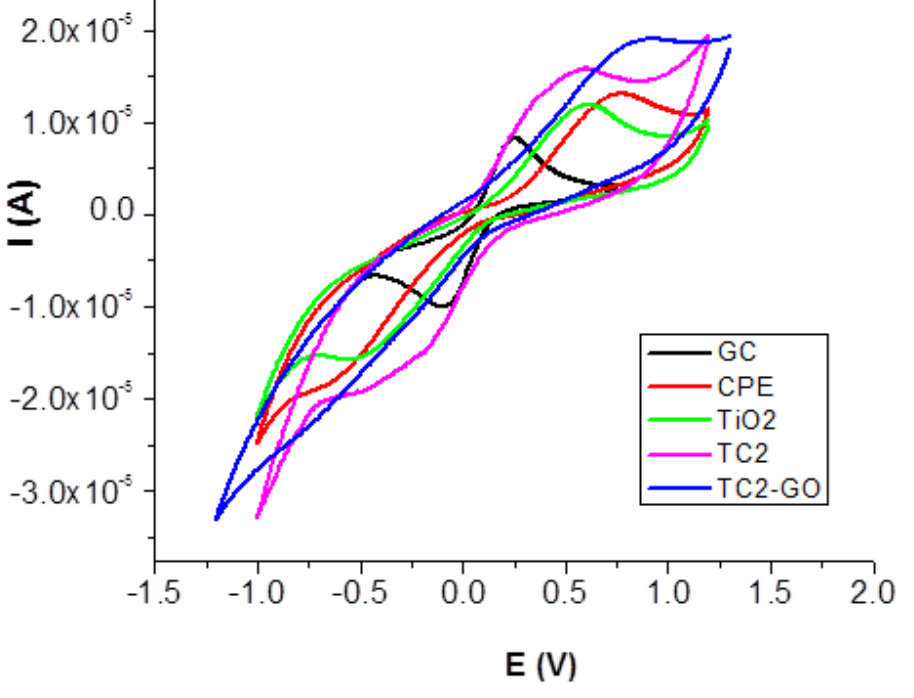
Figure 5. Overlay of the cyclic voltammograms for selected TC2 modified electrodes for the redox process of 1.0 mM K 3 [Fe(CN) 6 ] in 0.1 M KCl solution (scan rate was 100 mV s − 1 ).